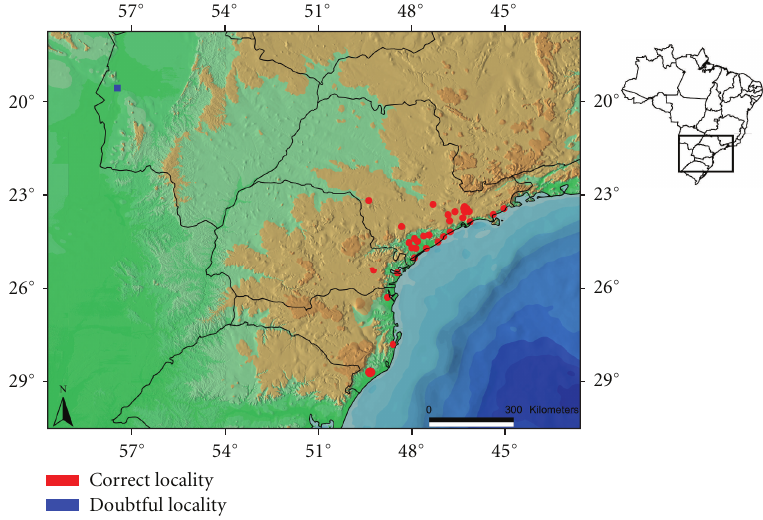
Figure 14: Distribution of Sordellina punctata